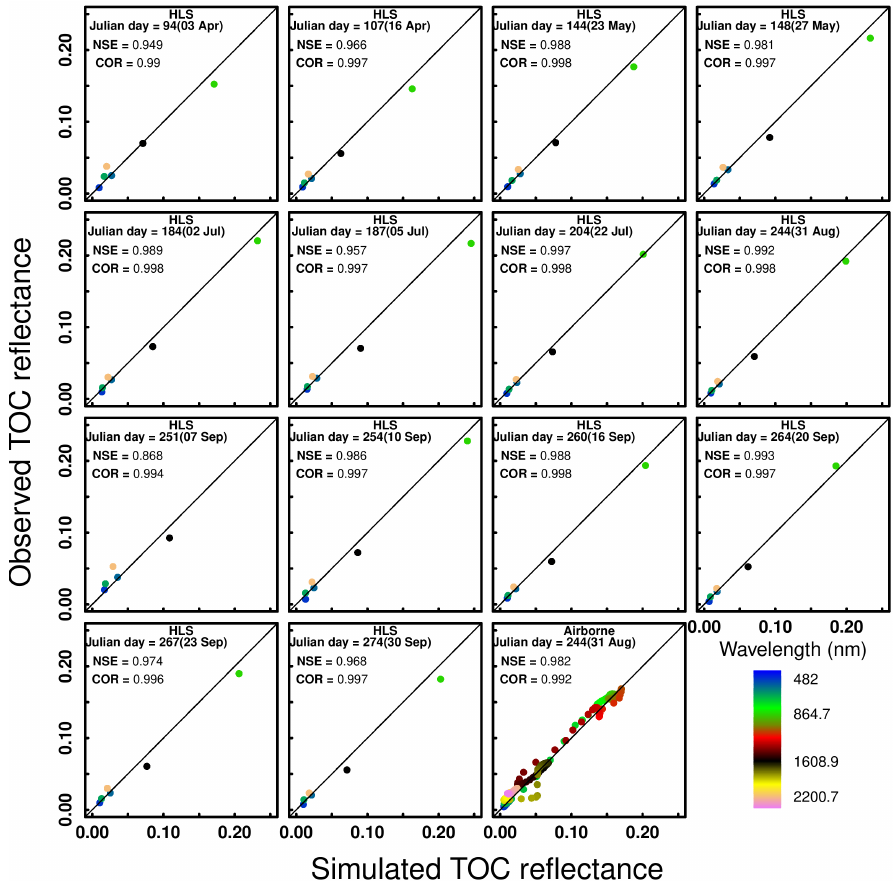
Figure 3. Scatterplot between the observed and simulated top-of-canopy (TOC) reflectance values for each of the 14 days during the 2016 vegetation growing season using the SCOPE radiative transfer module (RTMo). The last plot in the lowermost row shows the result for the airborne data; the other plots show the results for the harmonized Landsat-8 and Sentinel-2 (HLS) data. Values are color-coded by wavelength. The observed TOC reflectance represents the mean reflectance within the target area defined by the flux footprint (delineated in Figure 1). The correlation coefficient (COR) and Nash–Sutchliffe Efficeince (NSE) between observed and simulated TOC reflectance are shown in each